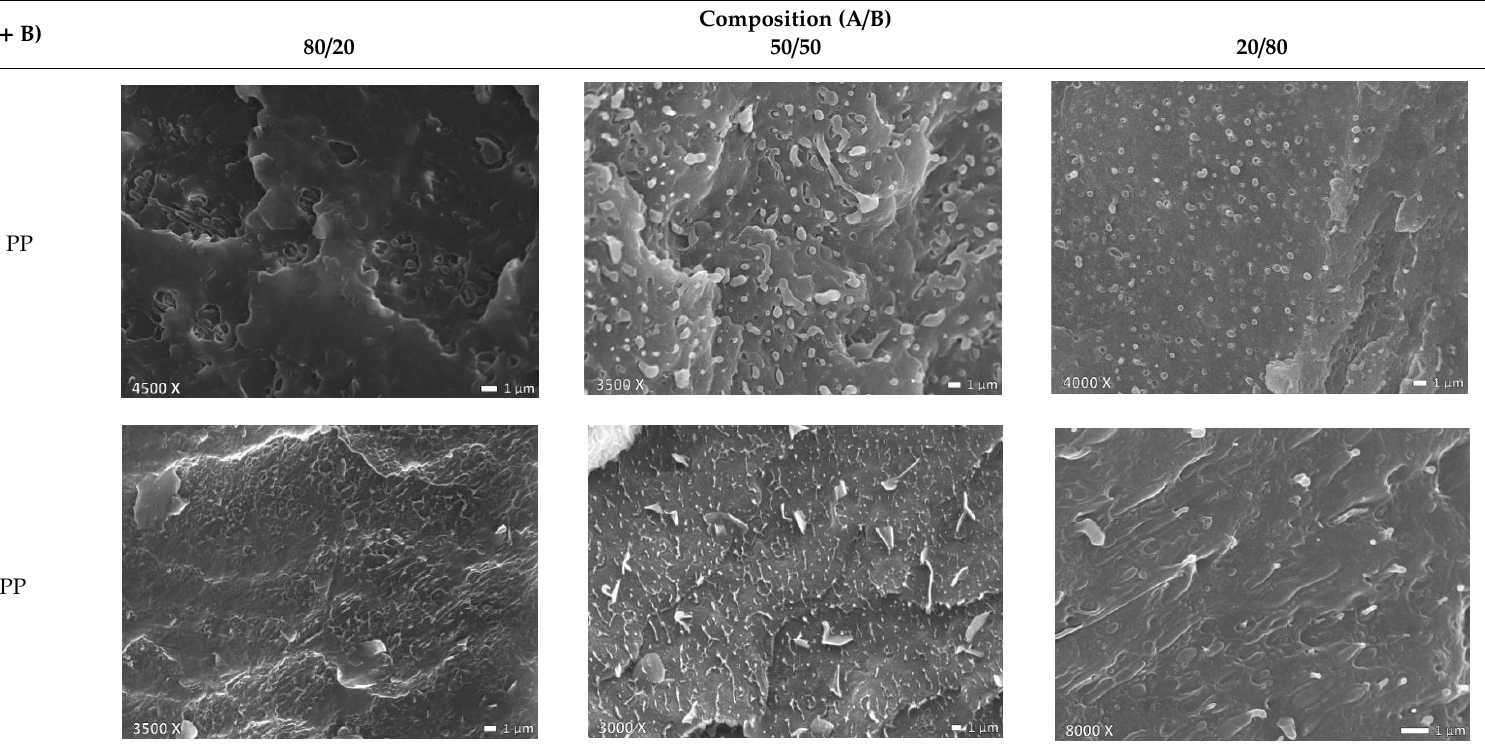
Table 2. Scanning electron microscopy (SEM) images of the 80/20, 50/50, and 20/80 ratios for the binary blends of PP mixed with LLDPE, LDPE and HDPE. LLDPE + PP: droplet/matrix morphology for all three ratios; LDPE + PP: 80/20 and 50/50 shows plastic deformation of the LDPE phase in contrast to the PP phase; HDPE + PP: 80/20 and 50/50 ductile fracture of the HDPE phase.